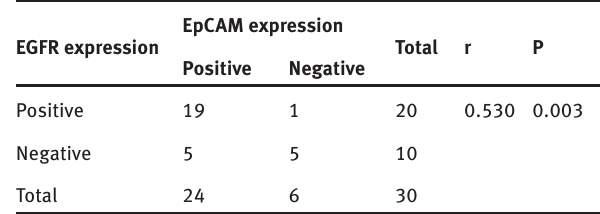
Table 4: Correlation between EpCAM and EGFR expression in